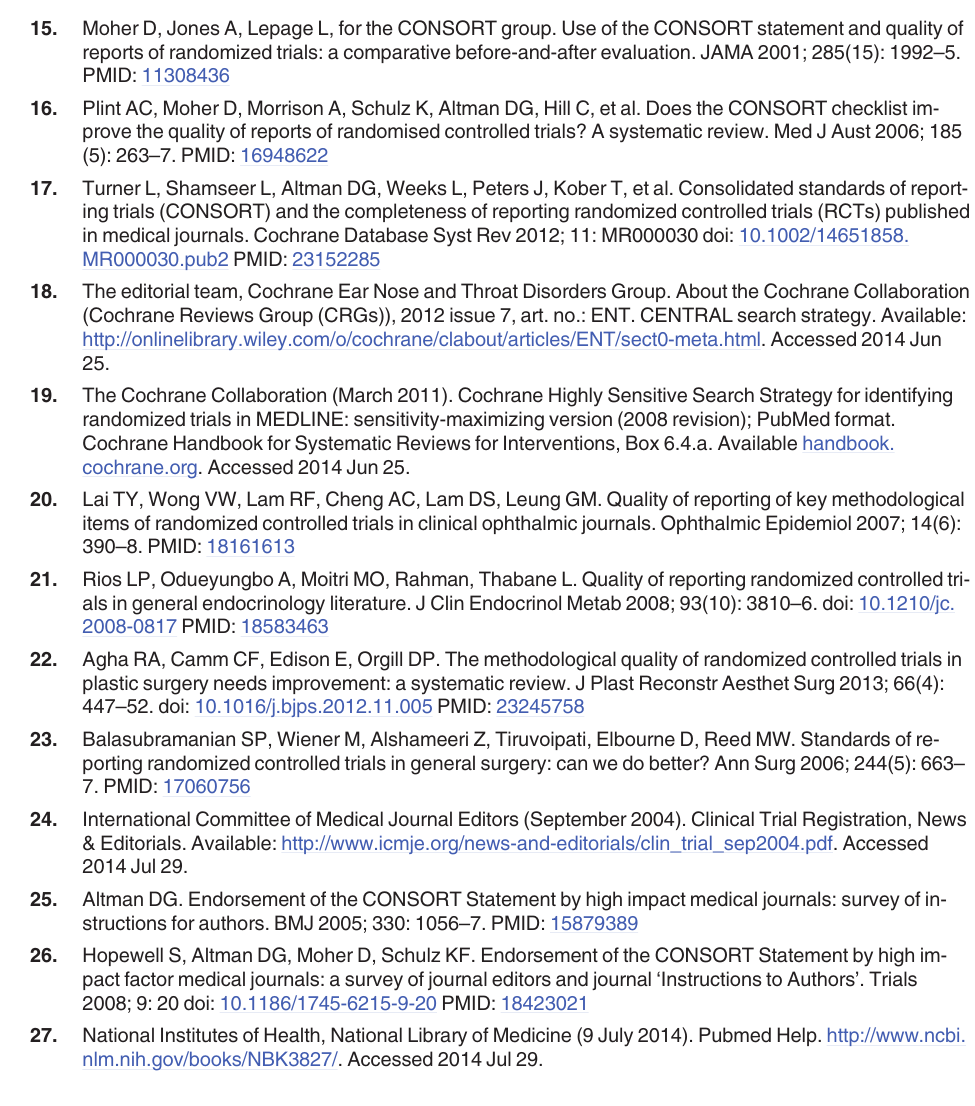
PLOS ONE | DOI:10.1371/journal.pone.0122328 March 20,